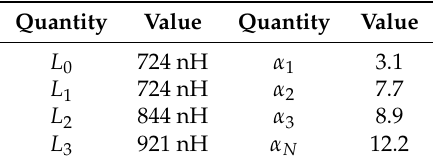
Table 3. Calculated network simulation parameters for the example capacitive power transfer (CPT)